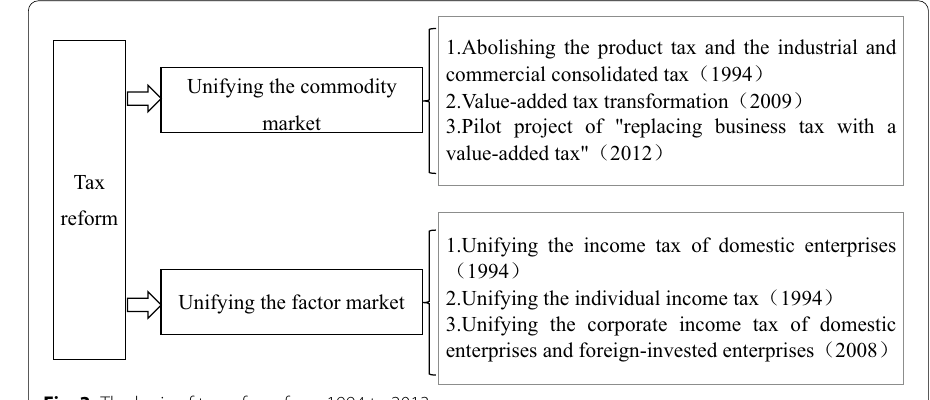
Fig. 3 The logic of tax reform from 1994 to